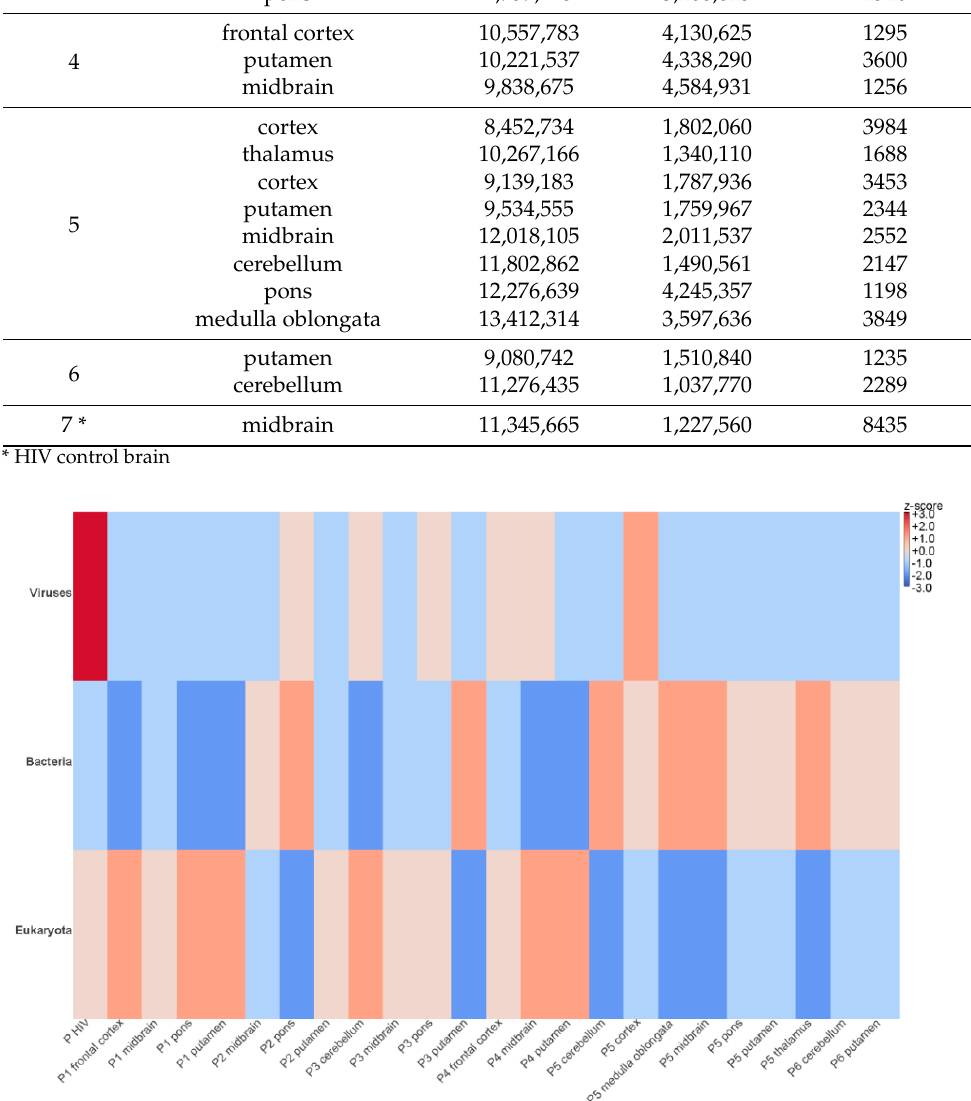
Figure 3. Heat map visualizing the abundances of eukaryotic, bacterial, and viral reads in each brain area from six patients with PEP. The brain regions of the PEP patients are listed in the bottom text row. The heat map is color-coded based on row z-scores; P HIV—brain from HIV infected patient used as positive control.